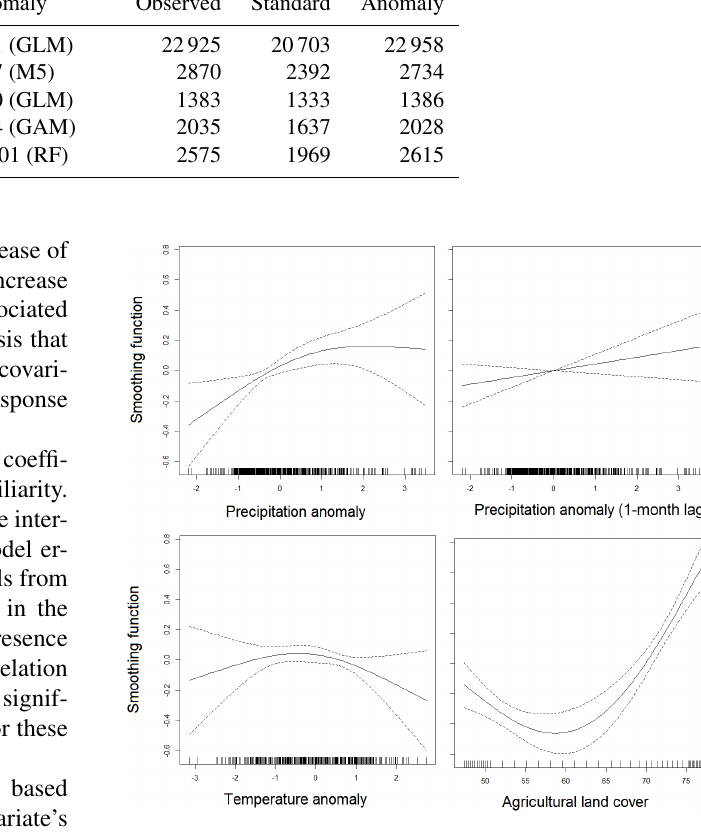
Figure 4. Plots of the smoothing functions used in the Megech River GAM. Hash marks along the x axis indicate observation val- ues of each